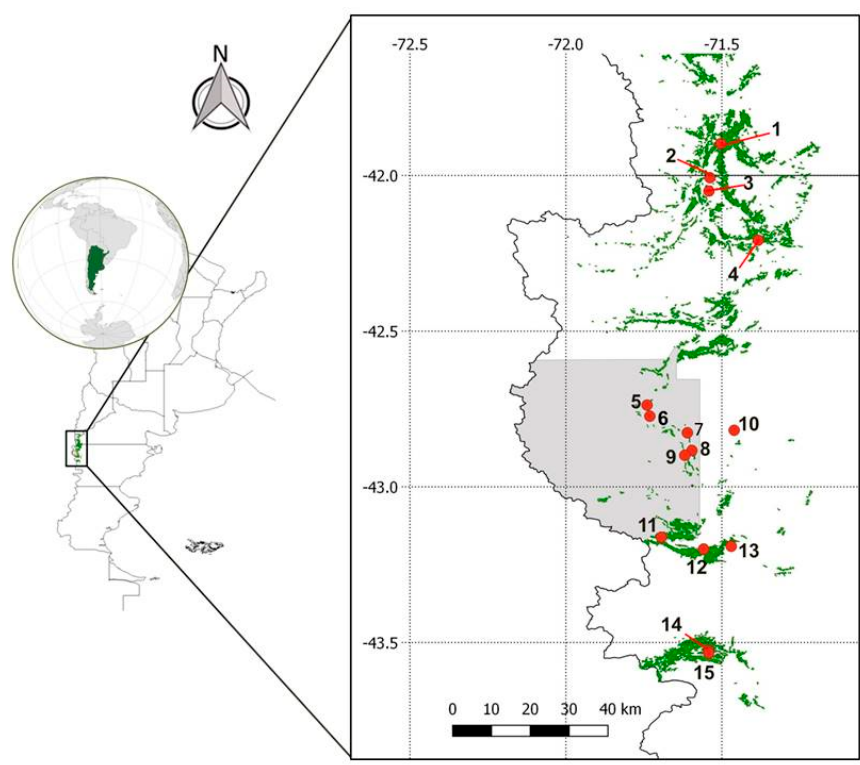
Figure 1. Distribution of Austrocedrus chilensis (D. Don) Pic. Sern. and Bizzarri forests in Río Negro and Chubut provinces, Argentina (source: Forest Inventory, report by CIEFAP, 2016) and location of sampling sites of the Phytophthora diversity study. Sampling site 11 coincides with the study area of Austrocedrus disease distribution over time. The sector shaded in gray corresponds to the protected area Los Alerces National Park.